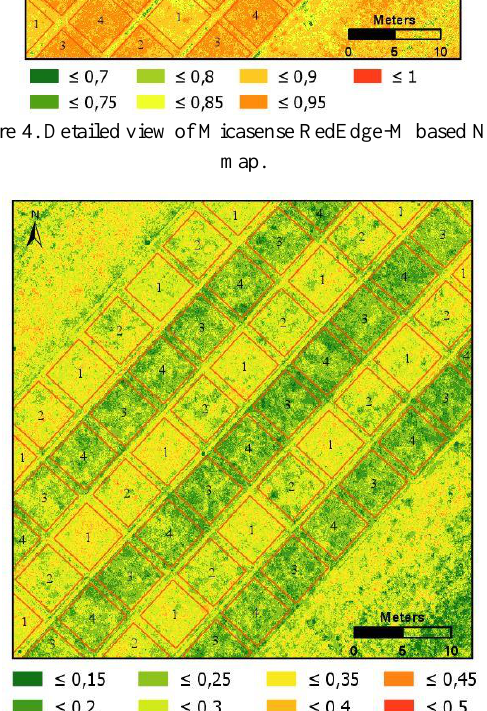
Figure 5. Detailed view of Sony Alpha based PPR map.